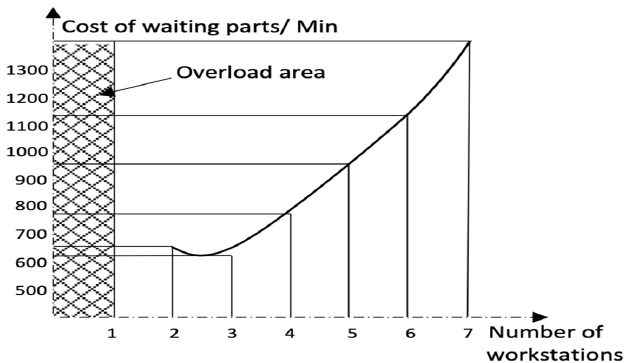
Figure 8. The output data with the elements related to optimization. In the C++ program, we simulated, during a maximum simulation period,